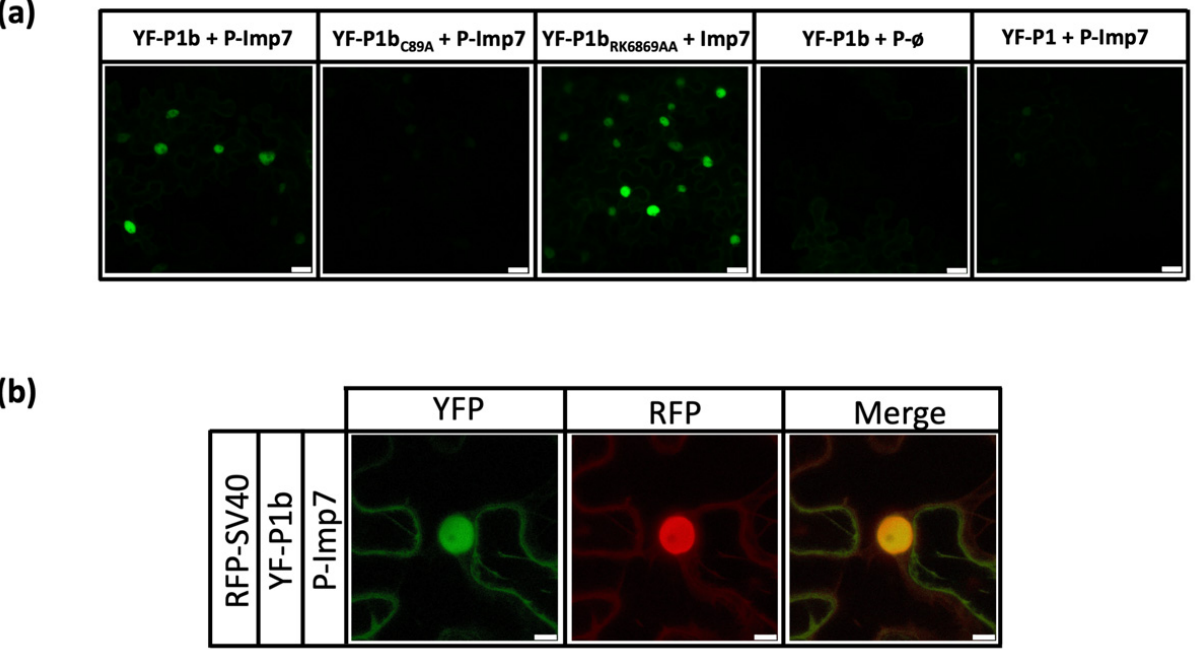
Figure 2. BiFC analysis to test the interaction of P1b with NbImp7 and its cellular localization. Images were taken with a confocal microscope at 6 dpa. ( a ) P1b and two P1b mutants, as well as P1, were expressed together with P-Imp7 and were tested for YFP fluorescence complementation. An empty plasmid, P-ø, was used as the negative control. The white bar indicates 25 µM. ( b ) YFP, RFP, and merge fluorescence of the same sample agroinfiltrated with the indicated constructs. The white bar indicates 10 µM.